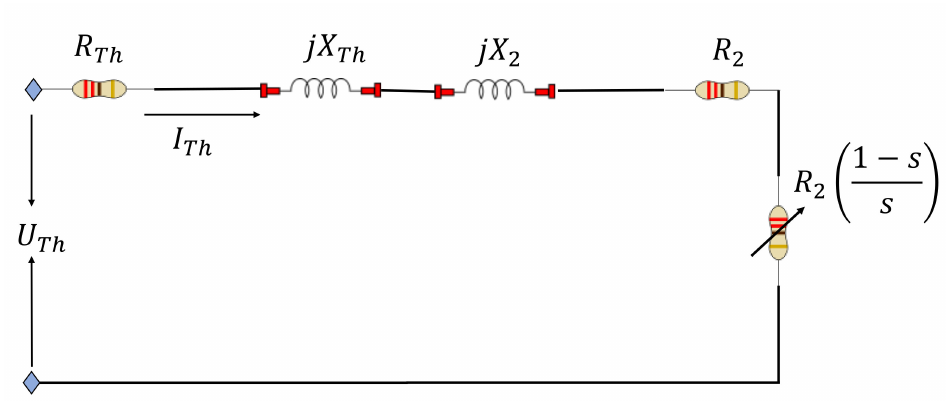
Figure 2. Thevenin single-phase equivalent circuit of AC